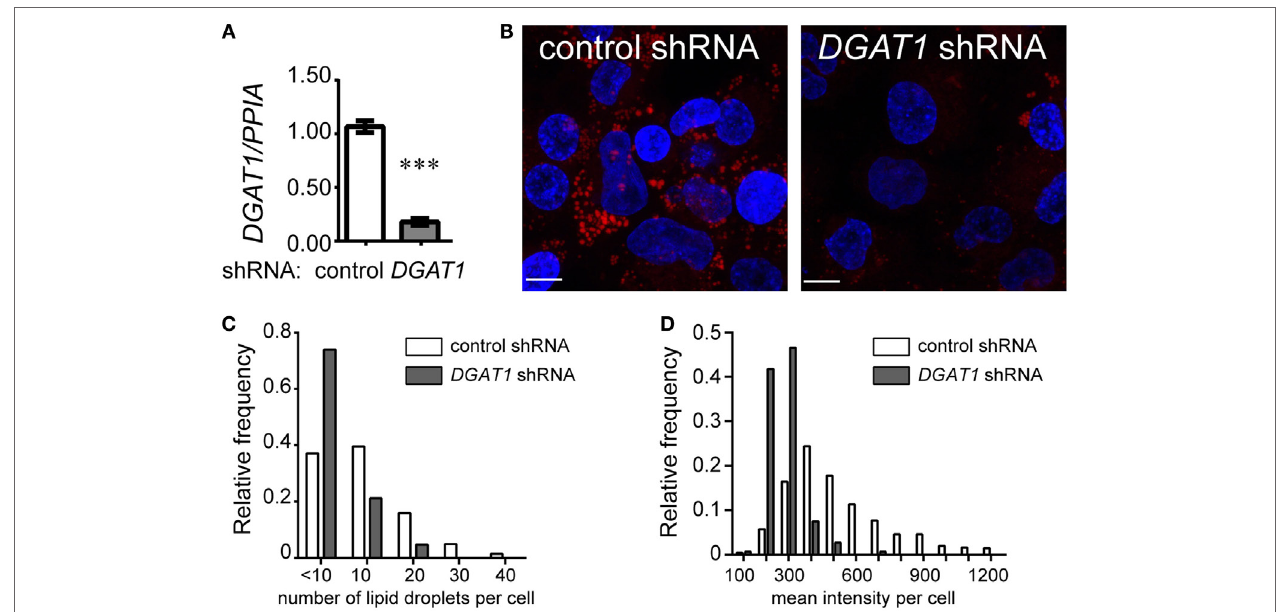
FigUre 2 | Triglycerides are the major neutral lipids in human THP1 macrophages. (a) DGAT1 expression in stable THP1 cell lines derived upon transduction with lentiviruses expressing non-targeting (control) and DGAT1- targeting shRNA. Data are mean ± SEM from three independent experiments. (B) LipidTox (red) and DAPI (blue) stained control (non-targeting) and DGAT1 shRNA expressing stable THP1 macrophages. Graphs representing distribution of lipid droplet size (c) and content (mean fluorescence intensity per cell) (D) from LipidTox stained images. Data are representative of 2 independent experiments. See also Figure S1 in Supplementary